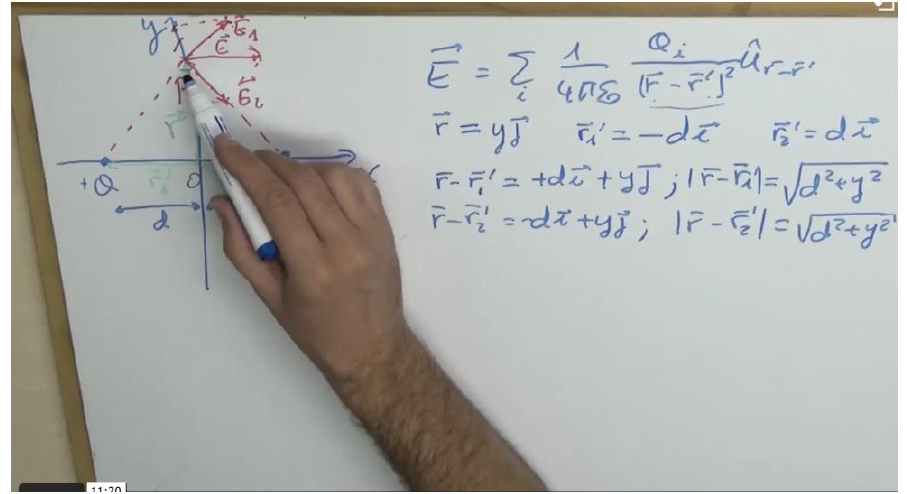
Figure 2. Example of a video with hands: https://vimeo.com/147752184. Table 1. Number of videos created with tablet and with hands. The number of videos of theory and problems is specified for each group (Theo/Prbl).